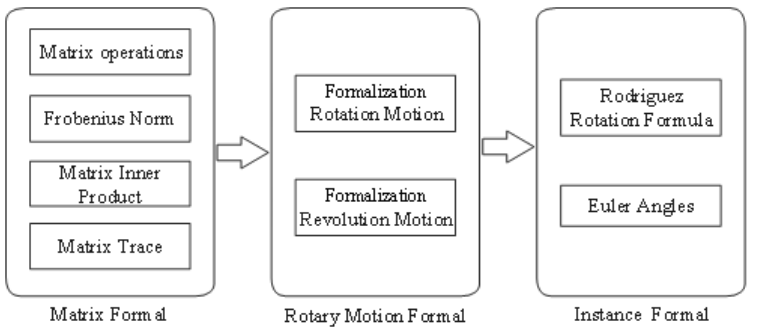
Figure 1. Formal framework of robot rotary